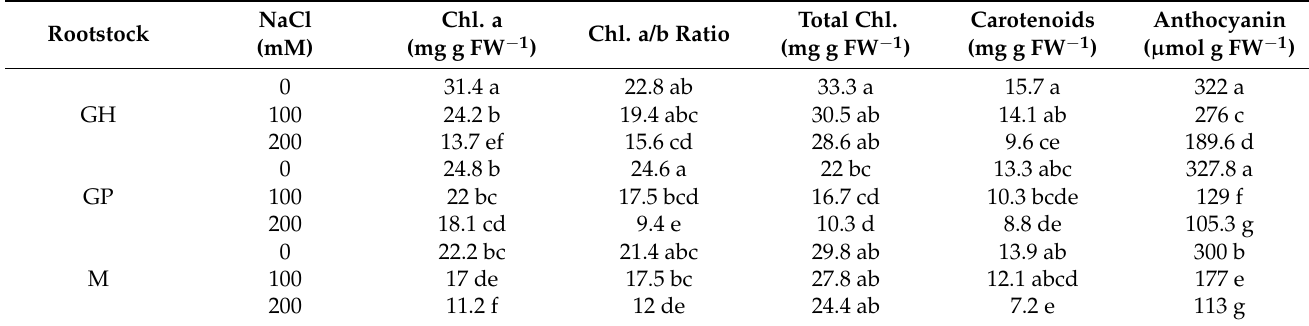
Table 2. Effects of salinity treatment on photosynthetic pigments (chlorophyll a, a/b, total), carotenoids and anthocyanin of three pistachio rootstocks including GH (Ghazvini), GP (Ghermez-Pesteh) and M ( P . atlantica subsp. mutica ). Rootstock